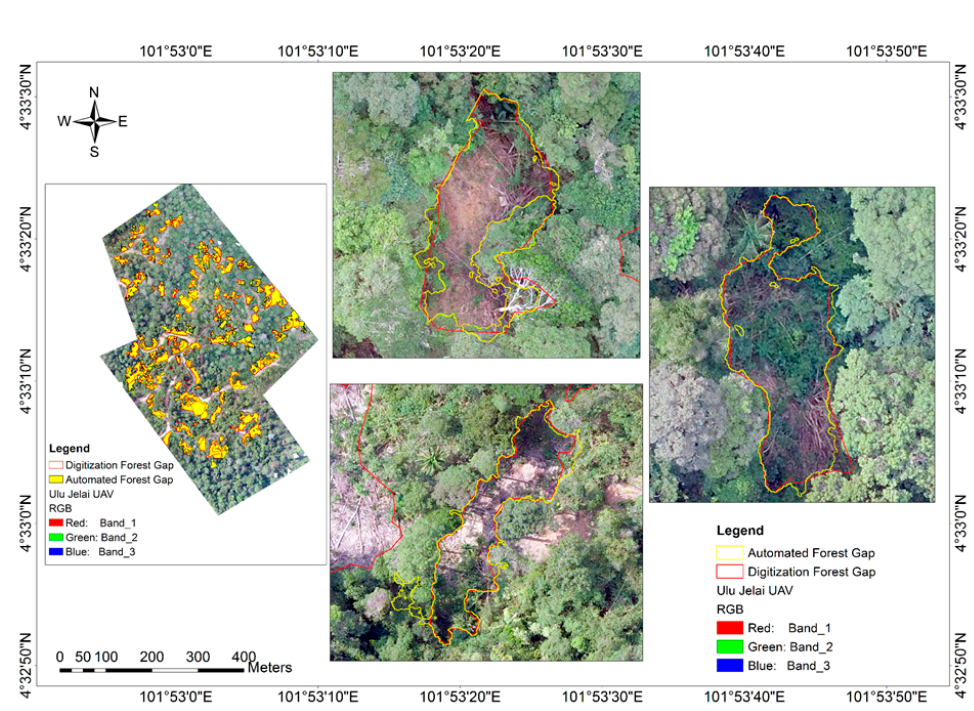
Figure 18. The differences in identifying forest canopy gaps using an automated vs. manual tech-